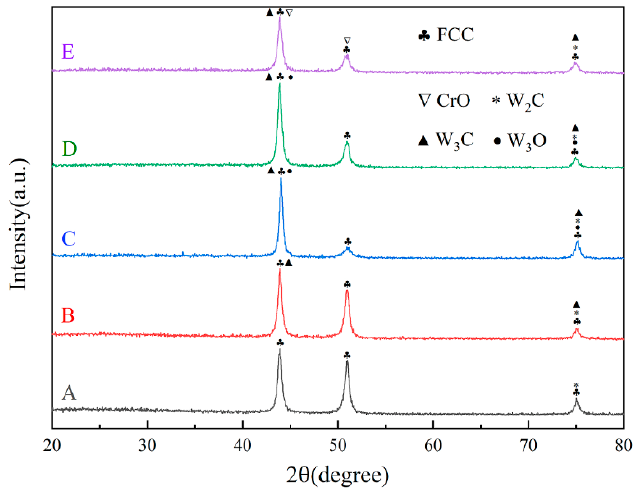
Figure 7. XRD pa tt ern of HEA/WC laser cladding coating.